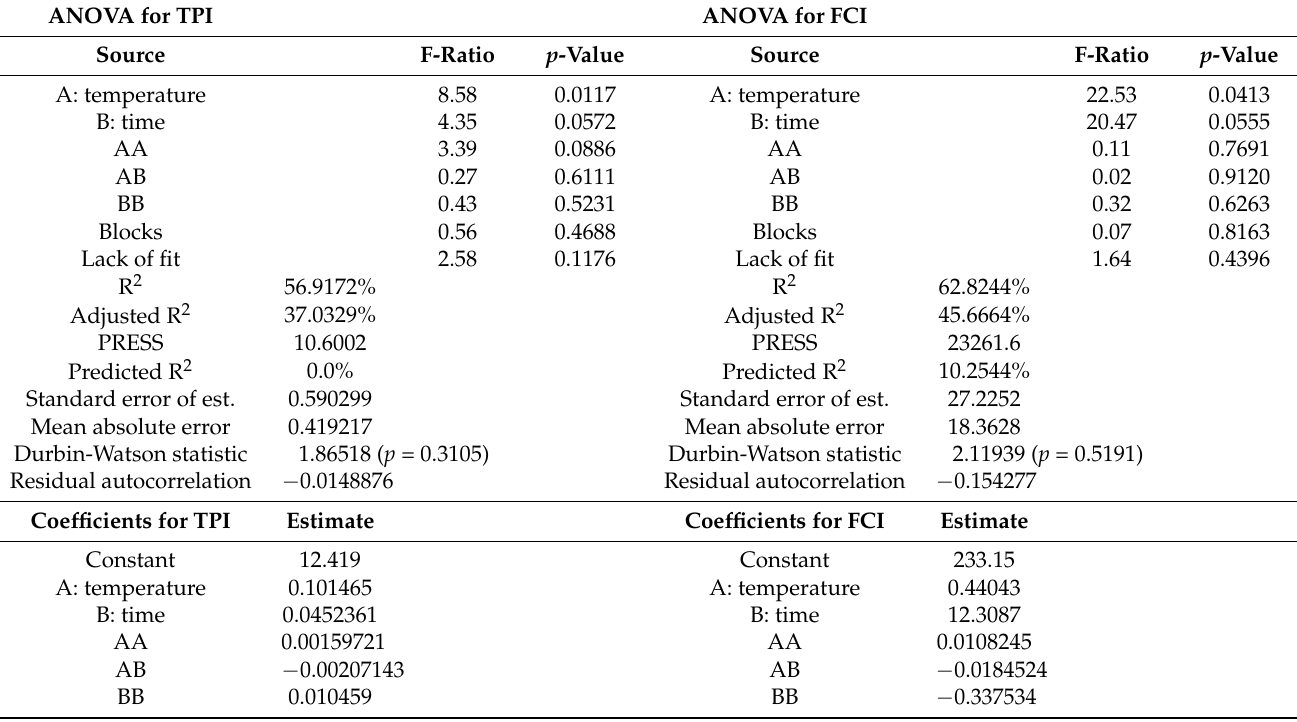
Table 2. Obtained parameters from the response surface model for Total Polyphenol Index (TPI) and Folin–Ciocalteu Index